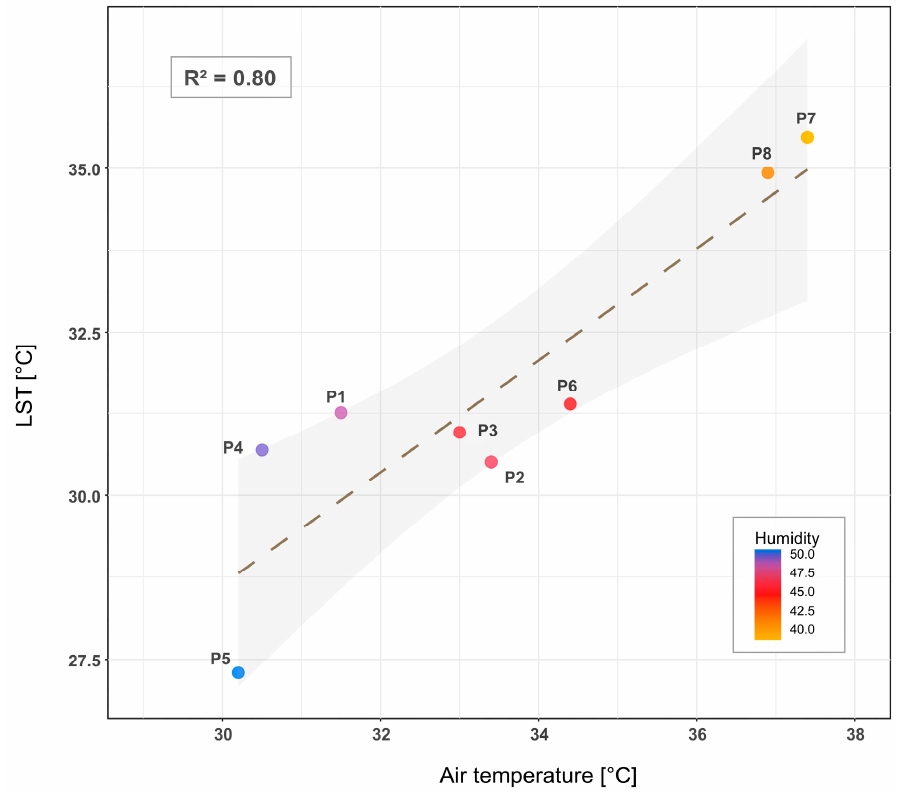
Figure 10. Comparison between observed air temperature and LST.